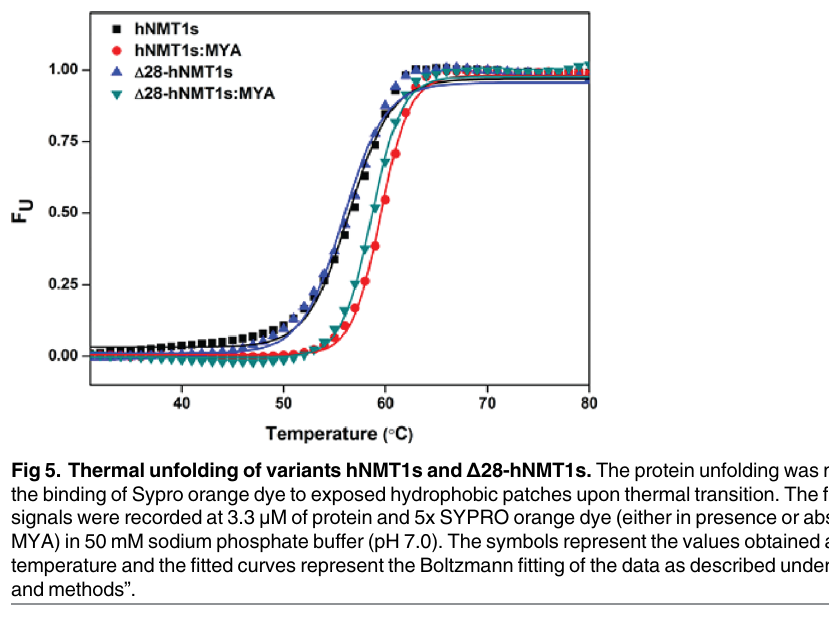
Table 2. Thermal stability parameters for full-length catalytic domain (hNMT1s) and N-terminal trun- cated ( Δ 28-hNMT1s) human N -myristoyltransferase 1 in apo and MYA bound states. Enzyme